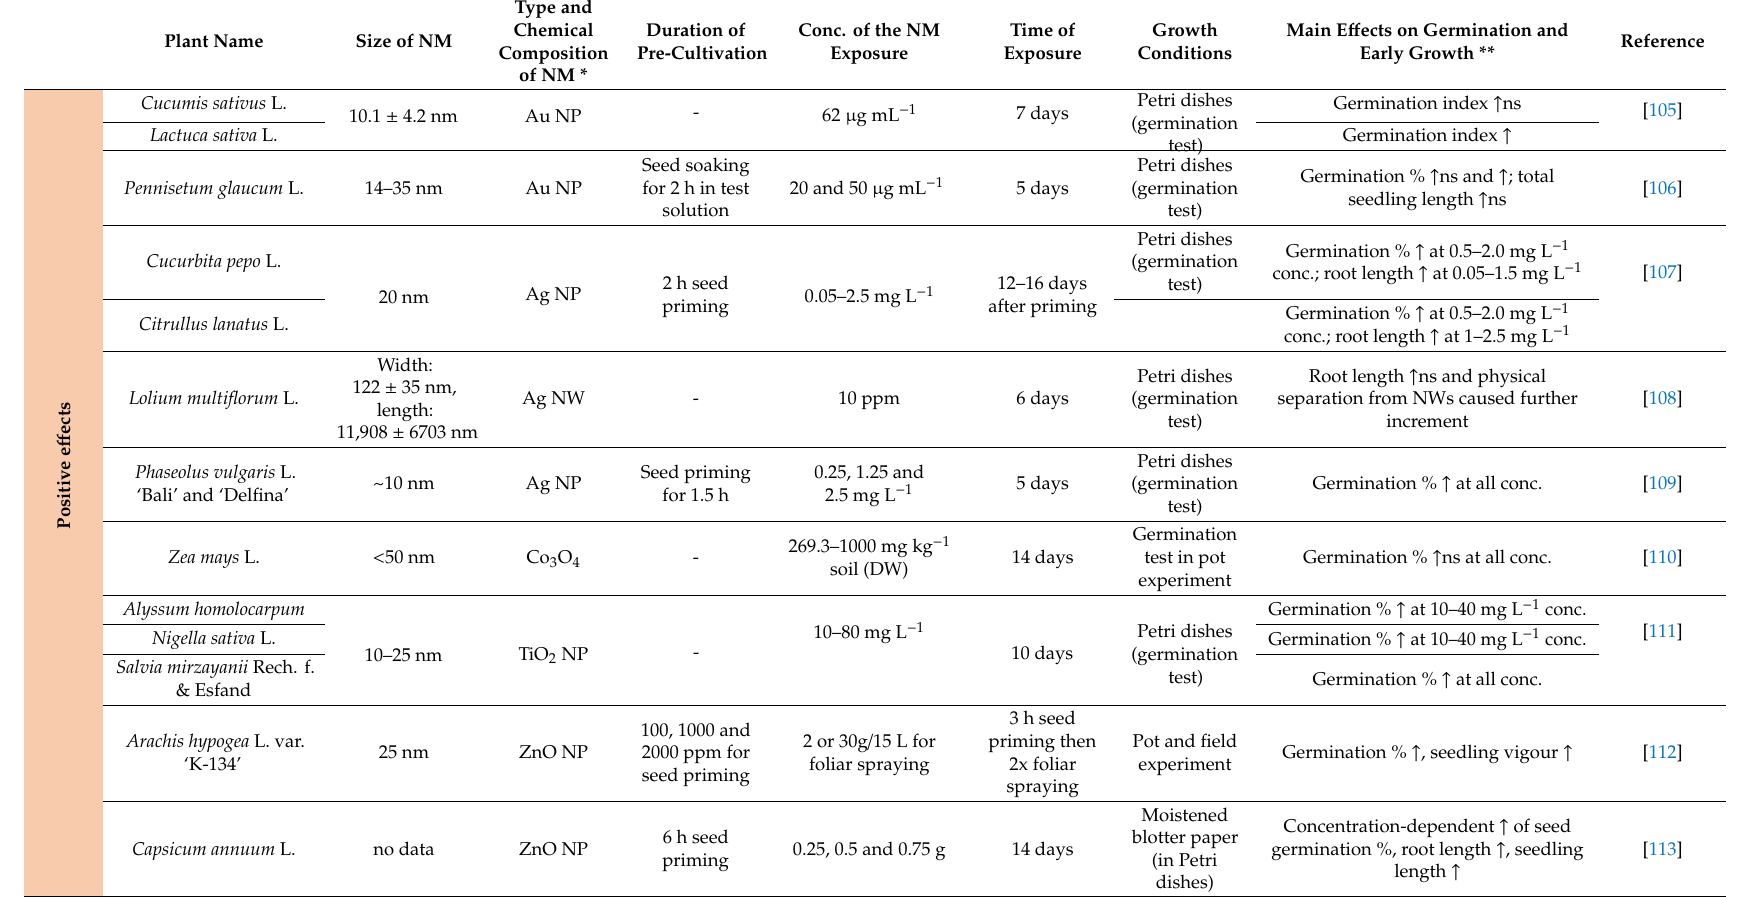
Table 1. Positive e ff ects of metal and metal oxide NPs on seed germination and seedling